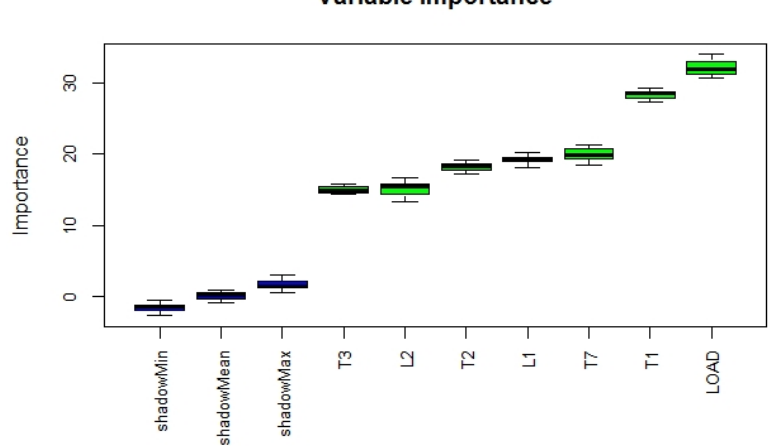
Figure 14. Boruta analysis for electricity price at 04:00.